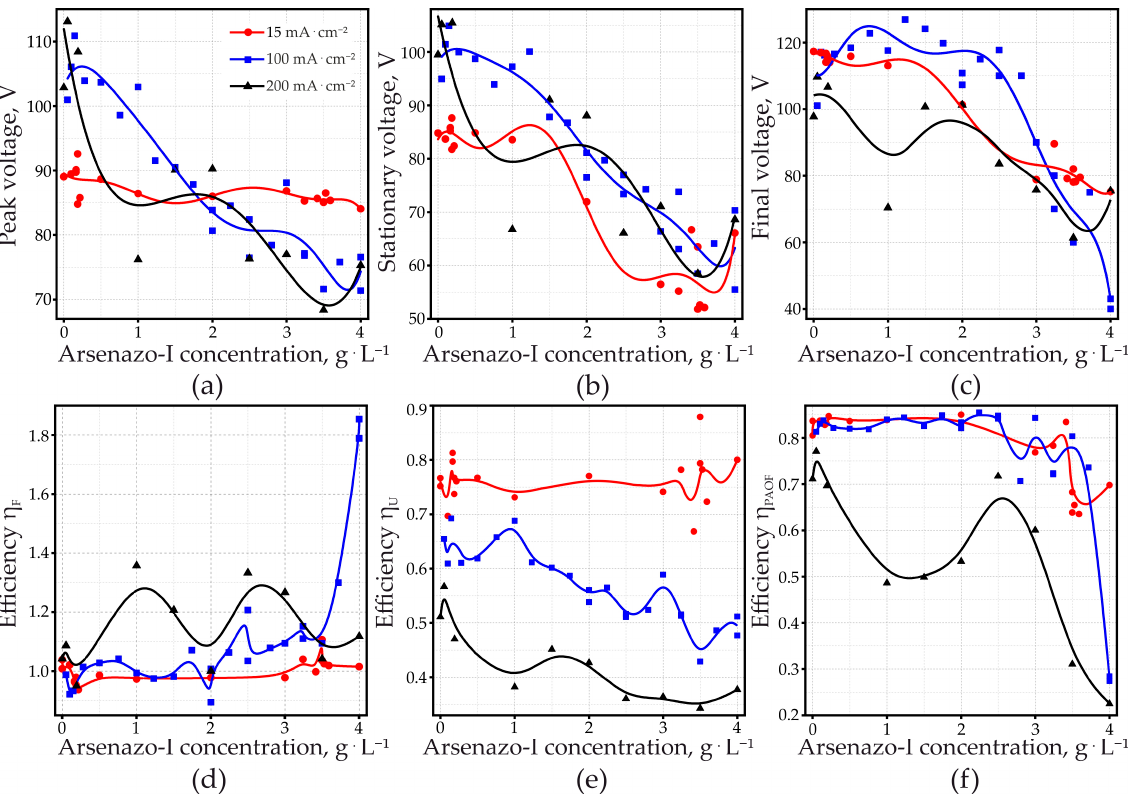
Figure 4. ( a ) Dependence of peak voltage, ( b ) stationary anodic voltage (showing the value measured at 50% of total applied charge), ( c ) and final voltage on arsenazo-I concentration for Al in 0.6 M malonic acid. ( d ) Current efficiency η F , ( e ) anodizing efficiency, obtained from d U /d τ η U , and ( f ) anodizing efficiency, obtained from dissolved Al 3+ − , η PAOF , as a function of arsenazo-I concentration. Galvanostatic anodizing with 15, 100, and 200 mA · cm − 2 , respectively.